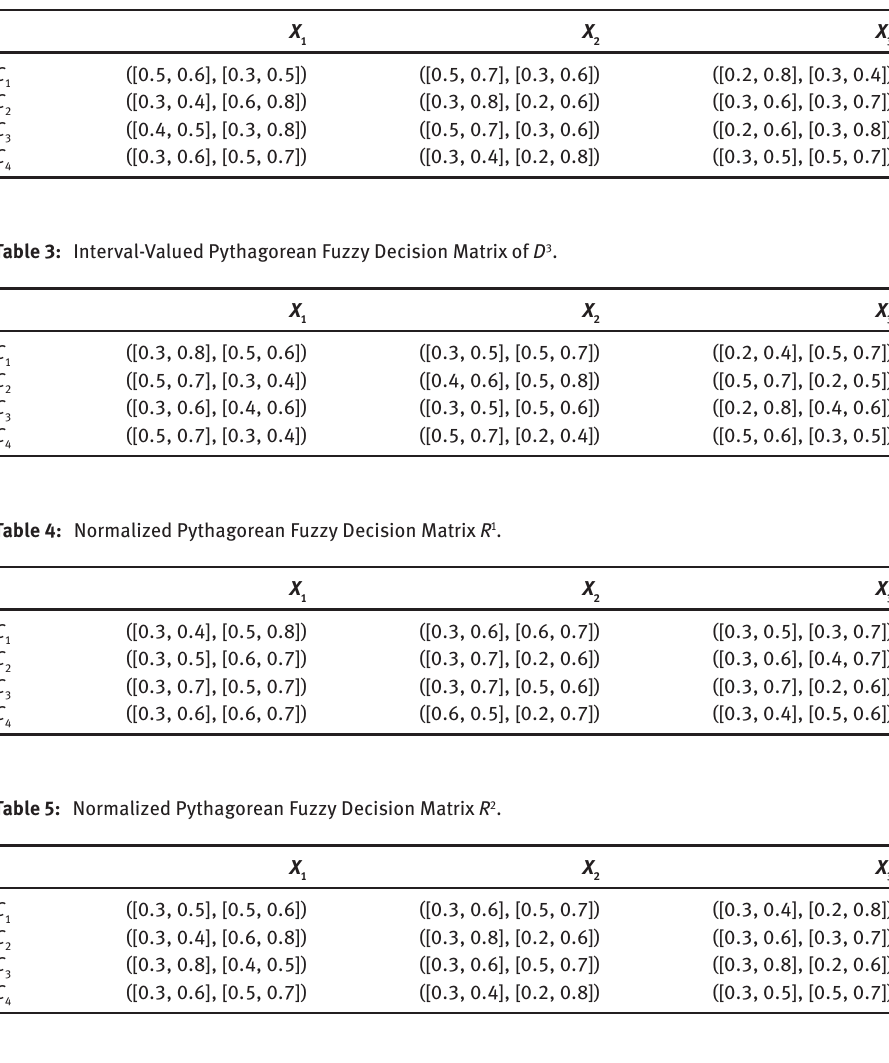
Table 2: Interval-Valued Pythagorean Fuzzy Decision Matrix of D 2 .